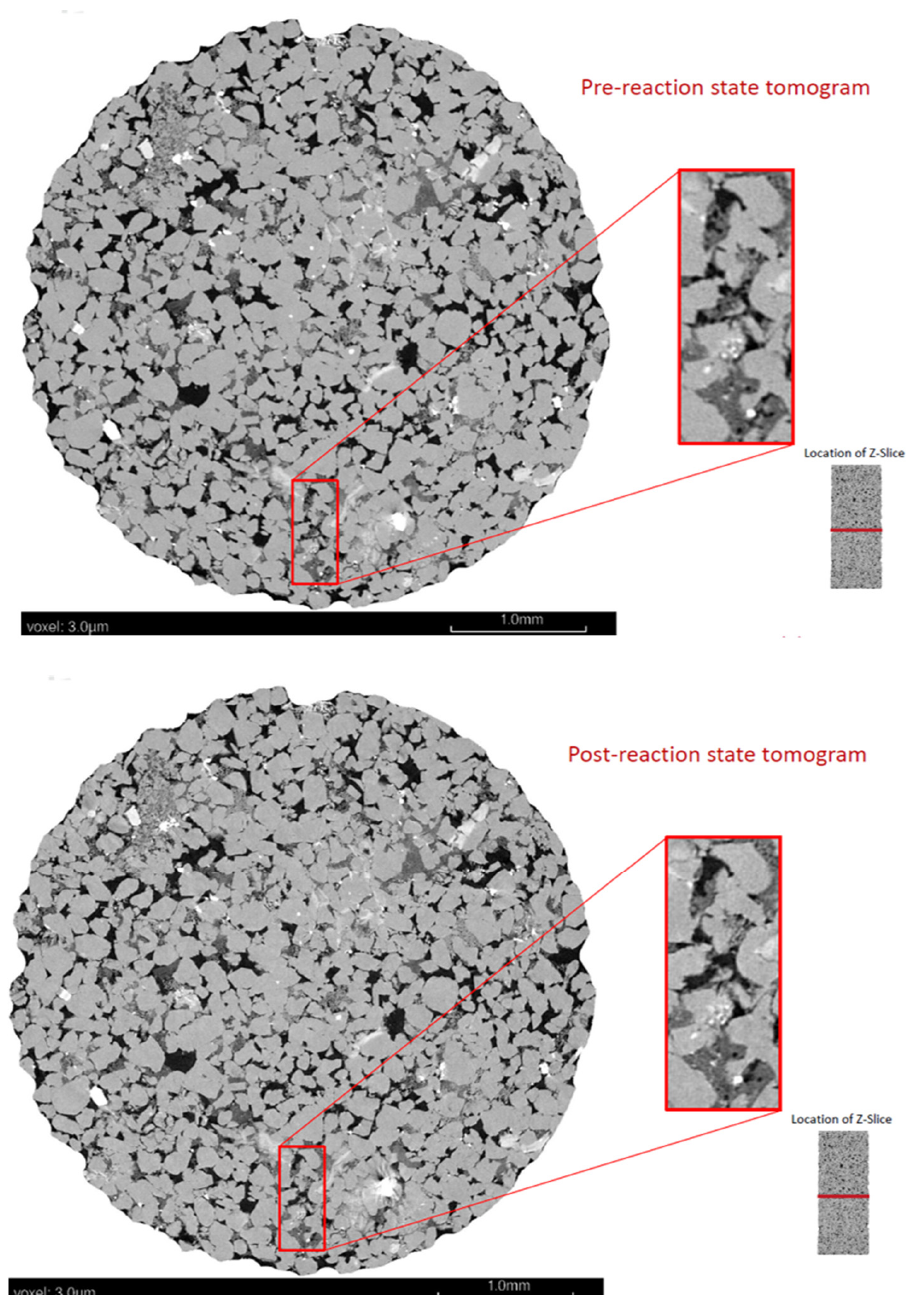
Figure 6. Pre- and post-reaction tomogram horizontal (z) plane images in a lower region. Magnified regions show changes and movement of pore bridging clays. The location of the image plane in the sub-plug is also indicated.